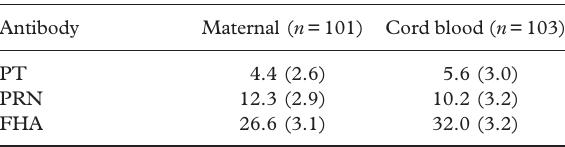
tion or geometric mean titer and maternal age. Table I. Geometric mean (SD) values for pertussis antibodies. Antibody